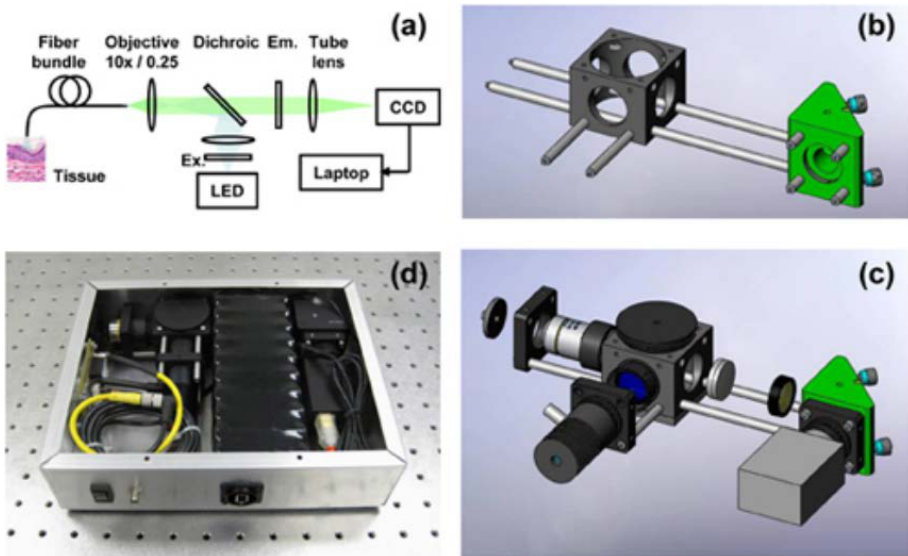
Figure 3. Schematic of HRME device used for fluorescence measurement of the cervical epithelium. ( a ) The optical schematic of the HRME system, ( b ) Opto-mechanical support structure assembly, ( c ) Opto-mechanical assembly with optical elements added, ( d ) Enclosed HRME system. (Reprinted with permission from Ref. [45]. Copyright 2022 MyJoVE Corporation).